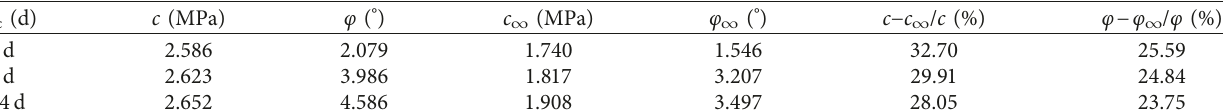
c : (a) friction angle and (b) cohesion.